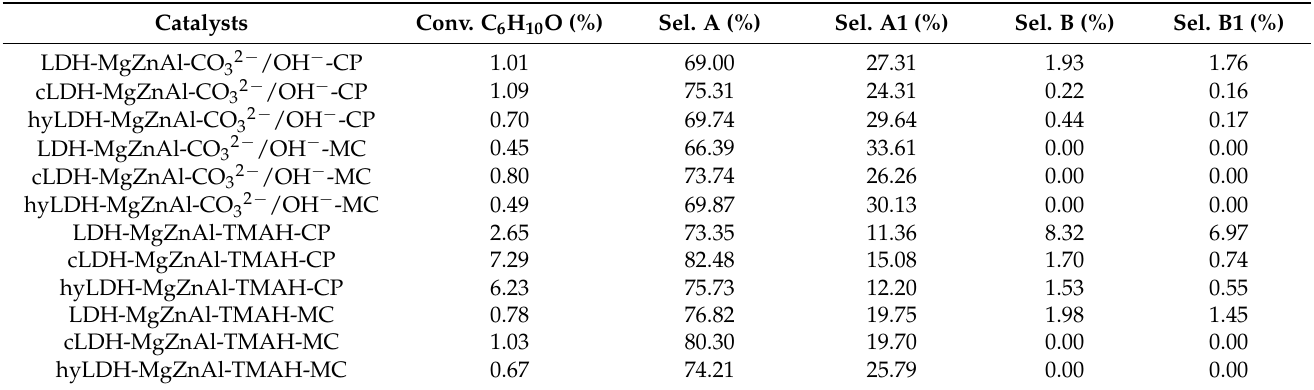
Table 3. Experimental data gathered for cyclohexanone conversion after 5 h, reflux, 5 wt.% catalyst, solvent-free.